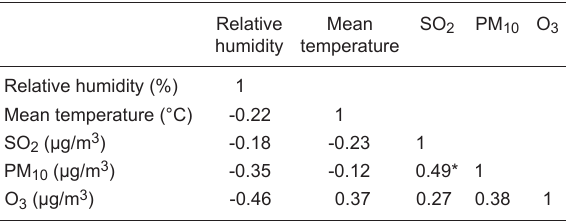
Table 2. Pearson correlation analysis of air pollutants and weather variables during the period